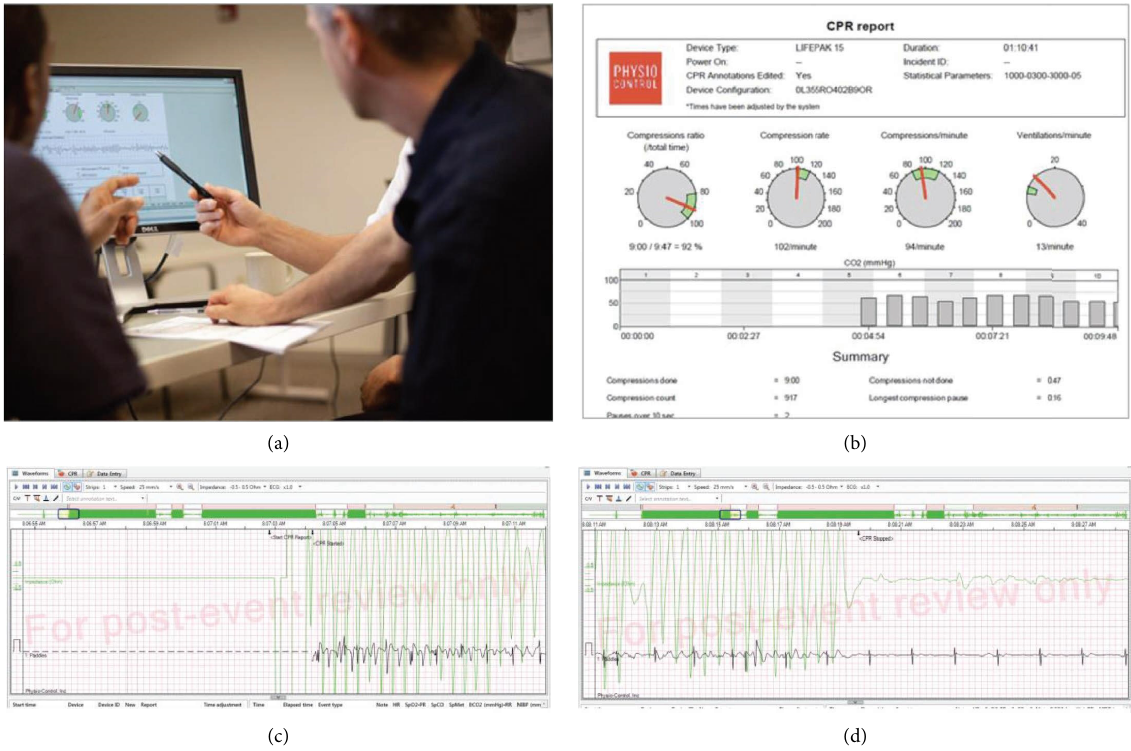
Figure 3: (a) Data-driven debriefng of CPR event using data from central monitor and defbrillation. (b) Code Stat ® dashboard displaying our team’s performance related to chest compression quality metrics during a CPR event. (c and d) Code Stat ® records of chest compression quality in a patient showing timing of the frst chest compression in relation to timing of the onset of cardiac arrest and chest compression interruption during CPR, respectively.